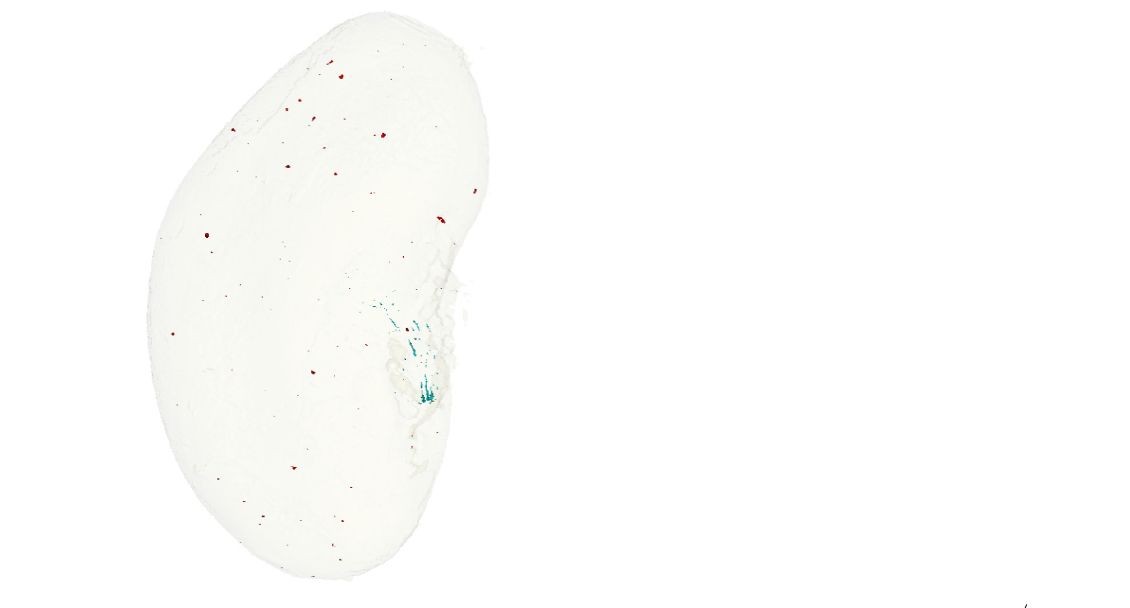
Figure 3. Representative 3D reconstruction (micro-CT) of one kidney from an Abcc6 − / − mouse exposed to high-calcium + vitamin D for 6 months. Calcifications (high-density areas) were stained in blue in the papilla (Randall’s plaque) and in red in the cortical and medullary areas.